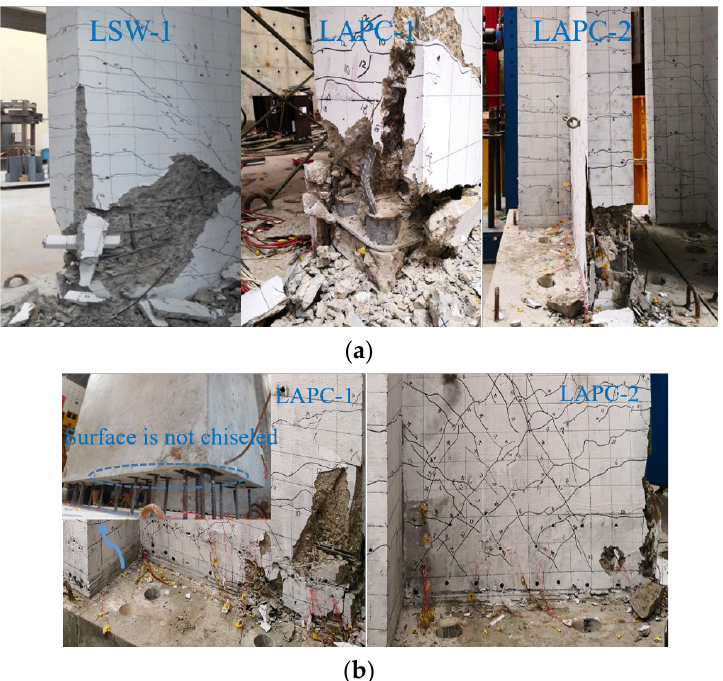
Figure 7. Failure of the root and grouting joint of L-shaped shear walls under ultimate load: ( a ) root of specimens; and ( b ) grouting joint of prefabricated specimens.